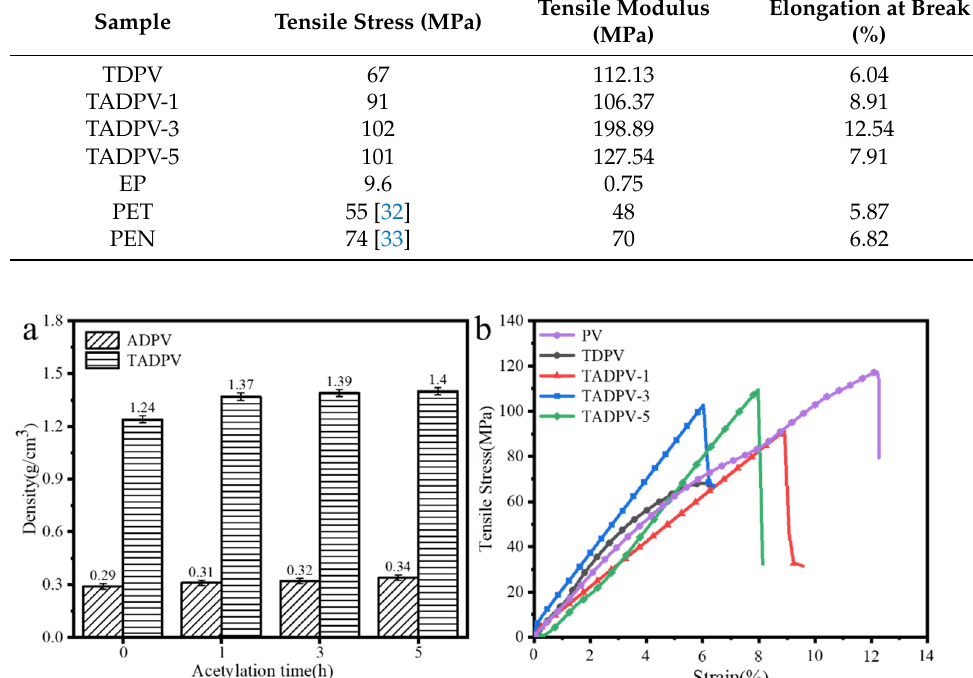
Figure 6. Variation of density and destruction forms of the interface of all specimens for ( a ) th vari- ation of density; ( b ) stress − strain curves; ( c – f ) the destruction forms of the interface of TDPV, TADPV-1, TADPV-3, and TADPV-5, respectively. Table 1. Comparison of the mechanical properties of all of the specimens and other plastic sub- strates. Sample Tensile Stress (MPa)